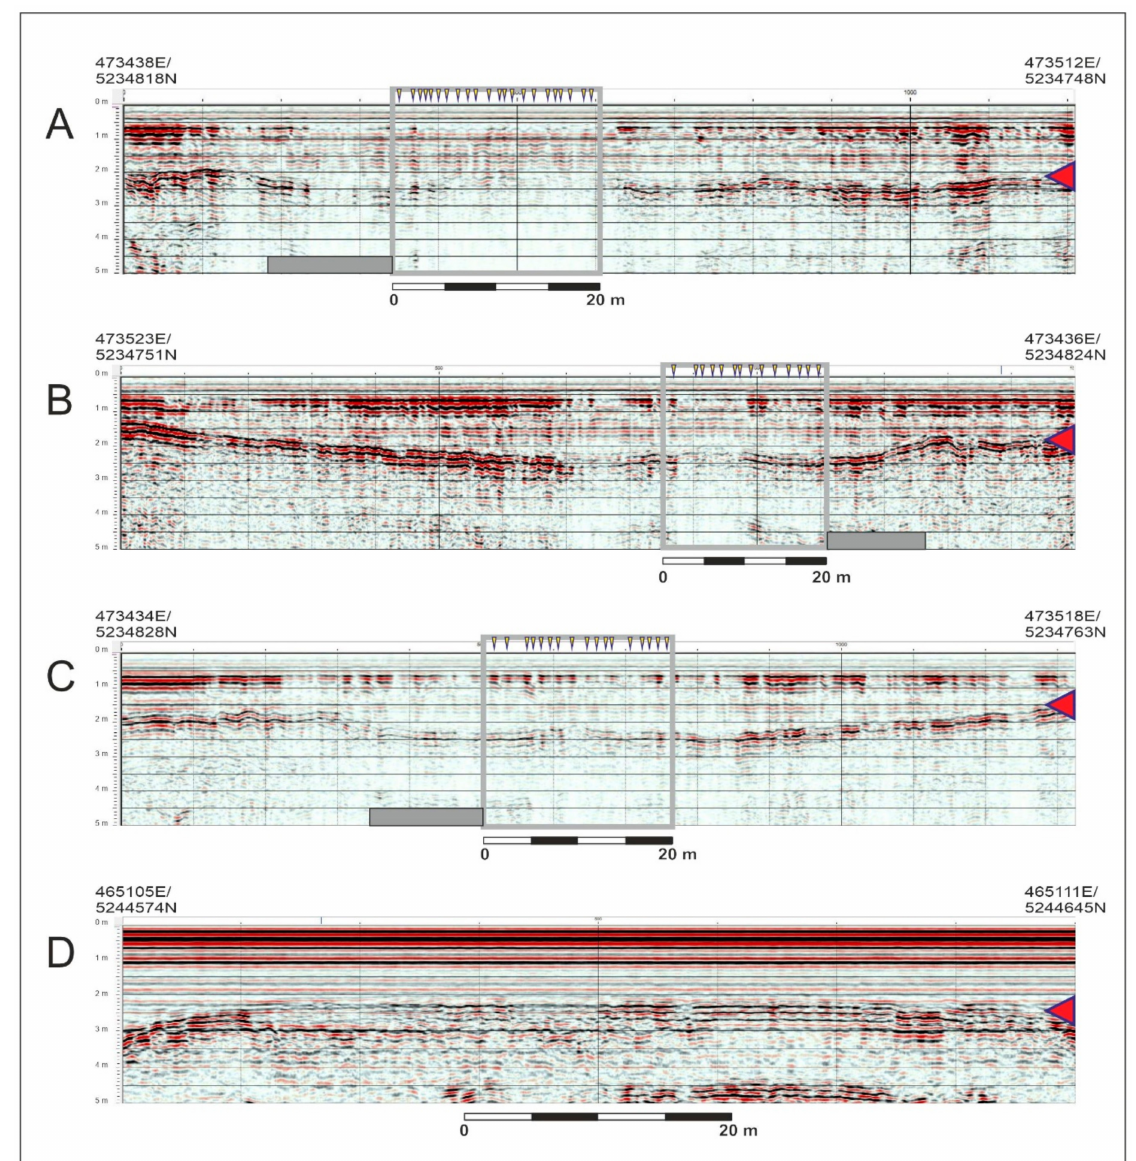
Figure 16. ( A – C ): Profiles through the 1975–1977 excavation area marked as a grey bar. The narrow noise columns 0–20 m east of the excavation area (grey square) are marked with yellow arrows from above. ( D ): Reference profile from Lake Zürich with no noise columns in the water phase but with its horizontal band of ‘top noise’ undisturbed. The seafloor is marked with a red arrow at the right side. The horizontal scale of the profiles varies with the speed at which they were recorded. Zone 33 UTM coordinates. Graphics: